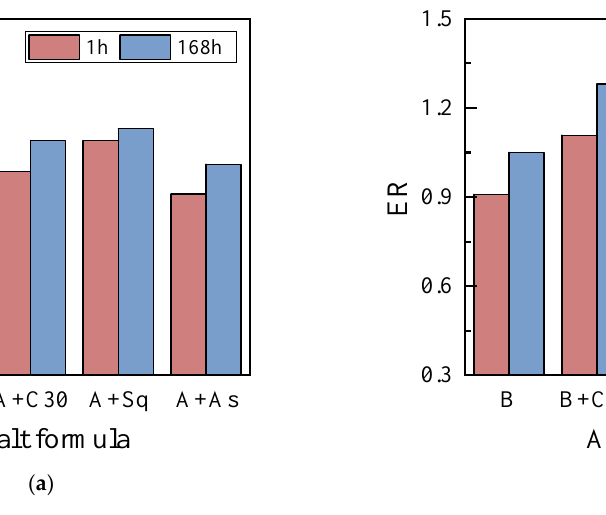
Figure 12. ER. ( a ) Asphalt A. ( b ) Asphalt B.